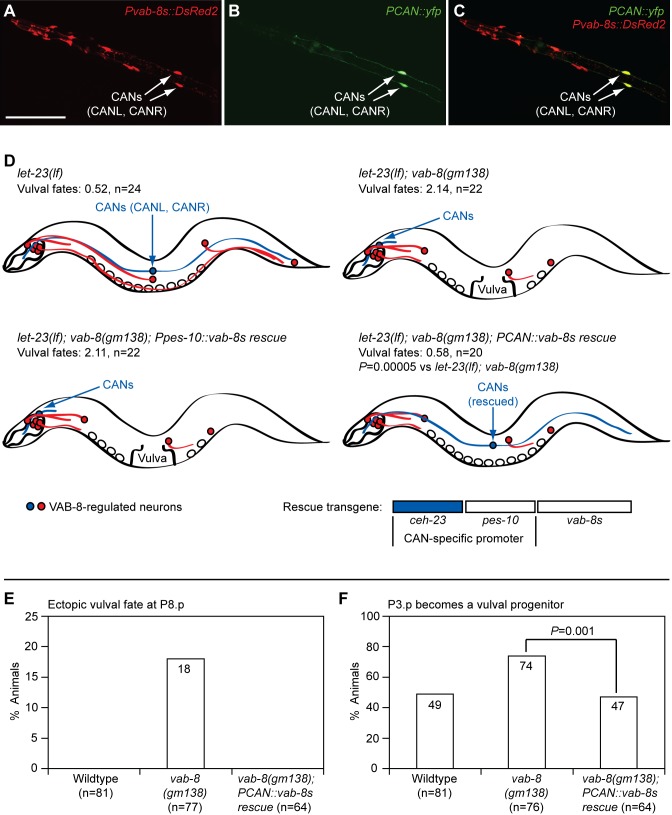
VAB-8 acts in the CAN neurons to regulate epidermal patterning.(A–C) Expression of vab-8s and CAN promoters from the akEx923 transgenic array in wild-type L2 stage animals. Scale bar is 50 µm. The CANs are a pair of neurons, CANL and CANR, located on the left and right side of each animal, respectively. (A) DsRed2 channel. (B) YFP channel. (C) Merged images from (A) and (B). (D) CAN-specific expression of VAB-8S restores inhibition to vulval fate signaling in vab-8 mutants. vab-8 mutations displace cell bodies and affect axon outgrowth of a subset of neurons including the CANs (blue). VAB-8S was restored to vab-8 mutants with either the CAN-specific promoter (PCAN) or the control minimal pes-10 promoter (Ppes-10). Vulval fates: number of vulval progenitor cells adopting vulval fates. Wild-type is 3.00. p-Value was calculated using a two-tailed Student's t test. Transgenic arrays were dyEx24 (Ppes-10::vab-8s) or dyEx20 (PCAN::vab-8s). CAN-specific expression of VAB-8S from the dyEx20 transgenic array rescues patterning defects in the posterior and anterior epidermis (E and F). p-Value was calculated using a two-tailed Fisher's exact test.